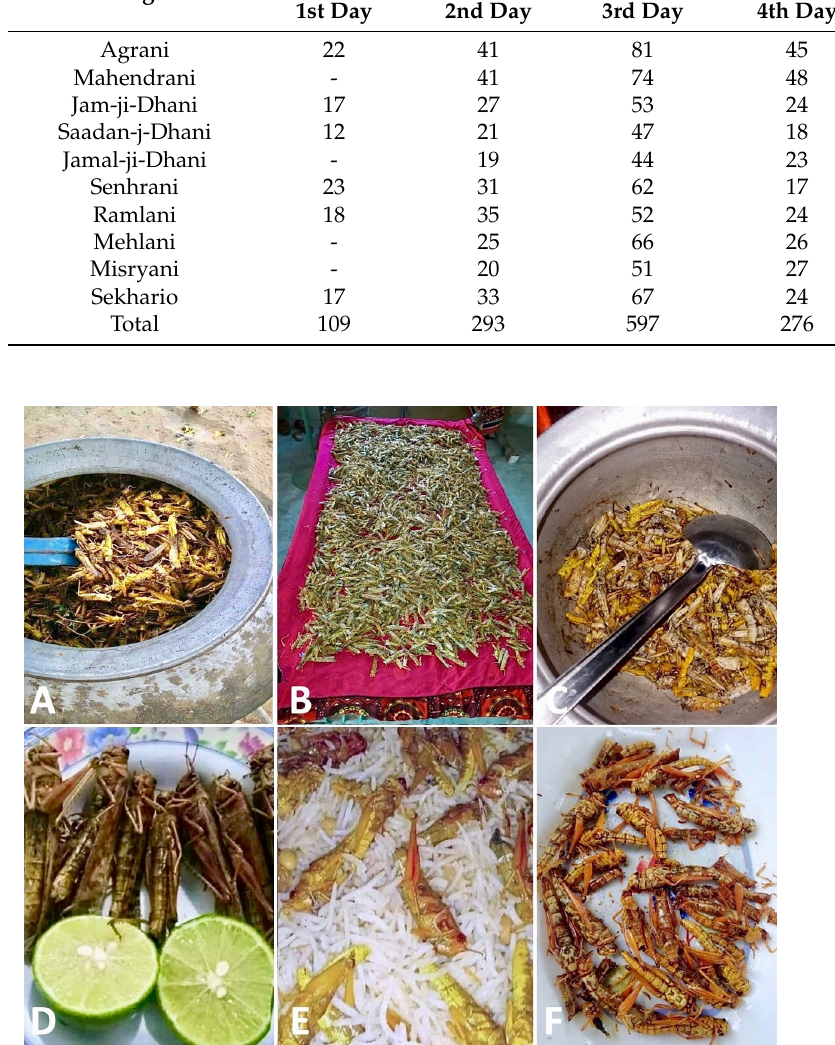
Figure 3. Various dishes based on desert locusts prepared by the Thari. ( A ) Locust boiling in water, (B) locusts spread out on a bed for drying, ( C ) cooking of dried locusts, ( D ) locust cooked with lemon, ( E ) “Biryani” (a typical dish of the Indian subcontinent) with locusts, ( F ) crispy locust snacks. Photos by Santosh Kumar, Nawaz Ali Samejo, Muhammad Ibrahim Samejo, Saraj-ud-din Samejo, and Samiullah Soomro.